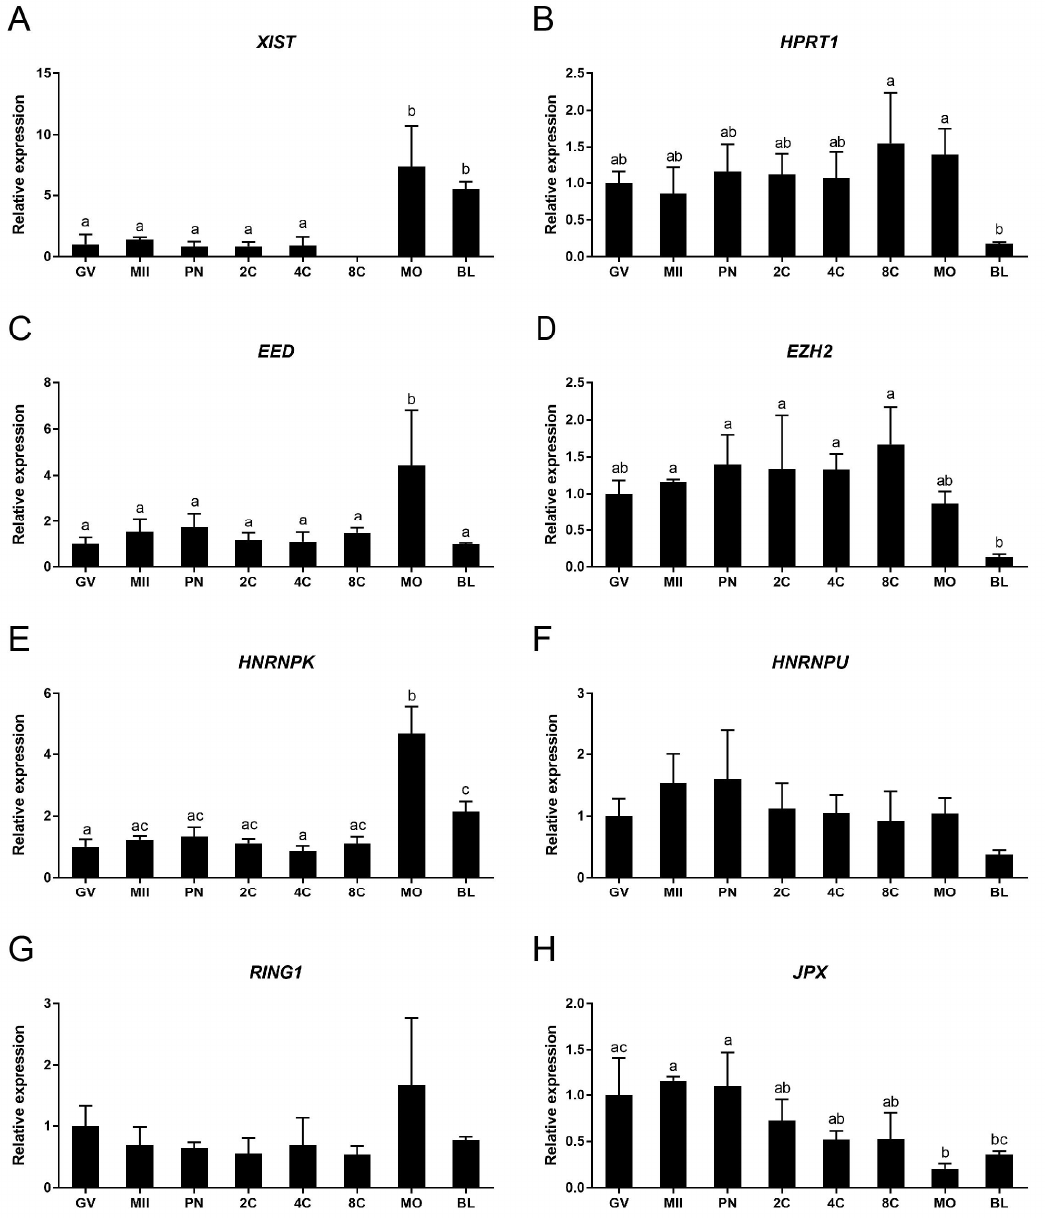
Figure 1. The relative expression of XCI related genes during in vitro bovine embryo development, as determined by quantitative RT-PCR. ( A ) XIST , ( B ) HPRT1 , ( C ) EED , ( D ) EZH2 , ( E ) HNRNPK , ( F ) HNRNPU , ( G ) RING1 , ( H ) JPX . GV, MII, PN, 2C, 4C, 8C, MO, and BL refer to germinal vesicle, metaphase II, pronuclear, 2-cell, 4-cell, 8-cell, morula, and blastocyst stages, respectively. Embryos were derived by fertilization with non-sexed sperm. Relative expression in GV oocytes set at 1. Significant differences between bars are indicated by different letters above bars ( p < 0.05). Error bars indicate standard deviations of three independent biological replicates.